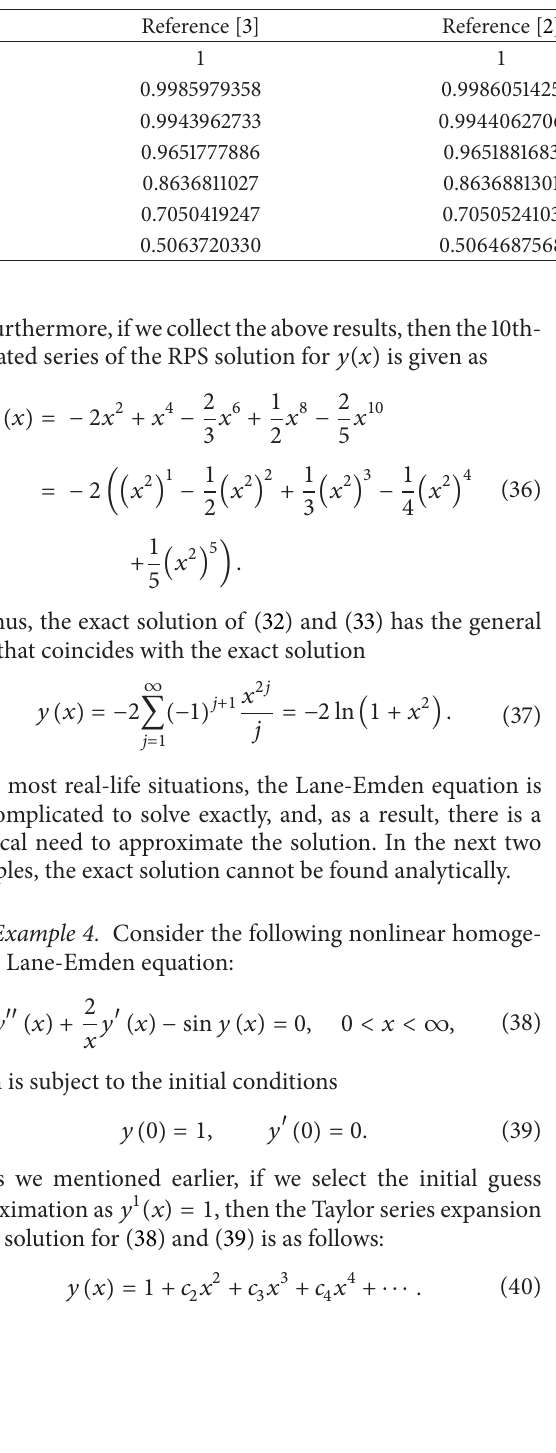
Table 3: A numerical comparison of the approximate solution to Example 4 for different values of 𝑥 in [0, 2]